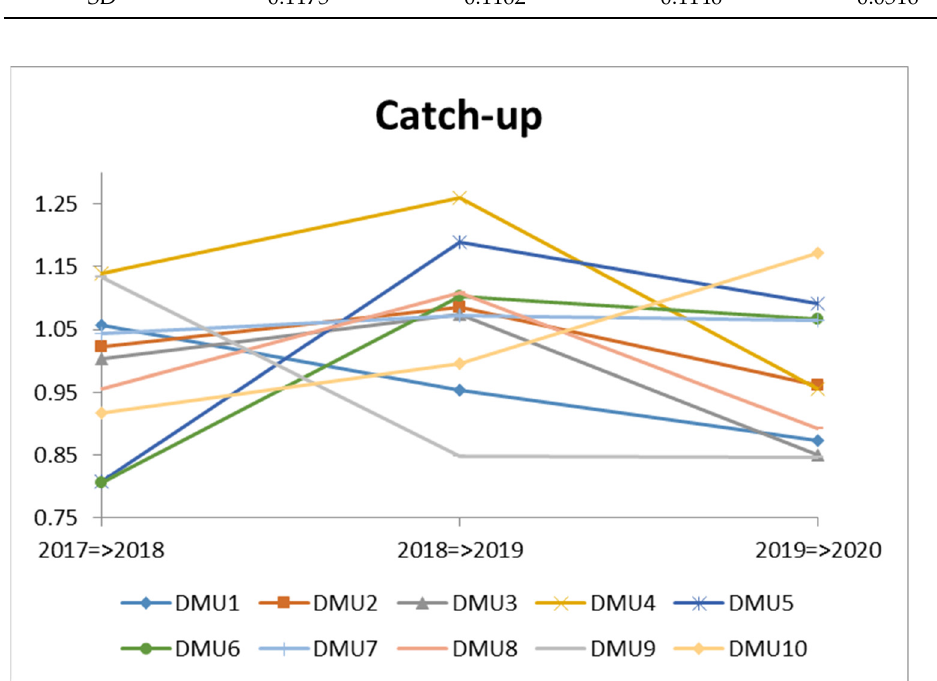
Figure 5. The technical efficiency change (catch-up) of DMUs (2017–2020).